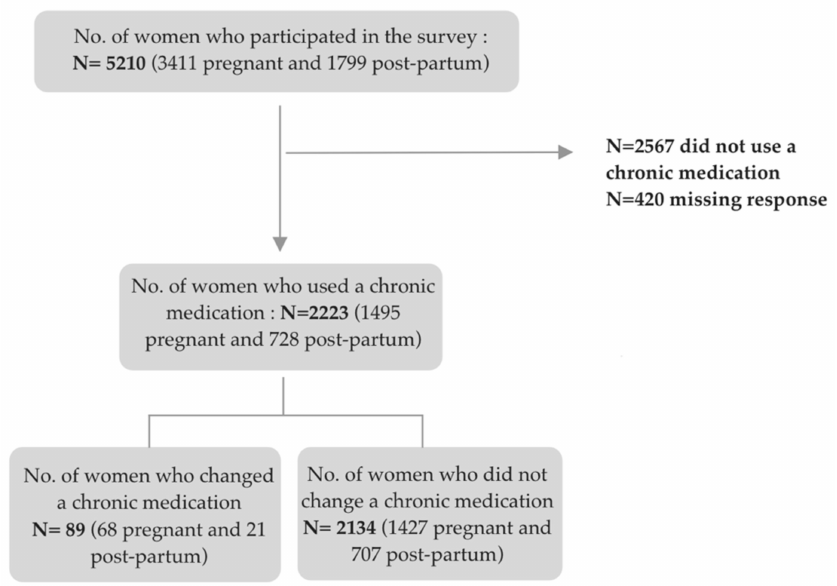
Figure 1. Flowchart of the study